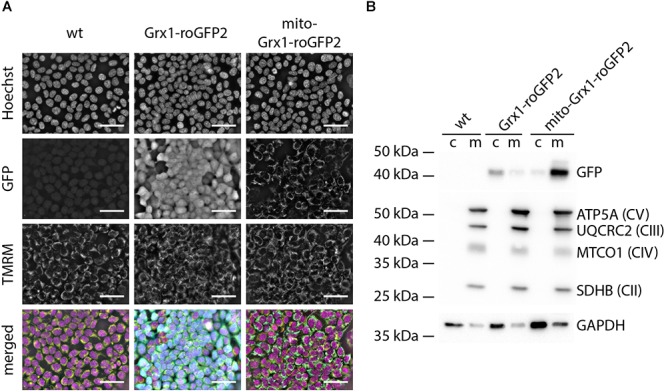
TSA cells express Grx1-roGFP2 in a compartment specific manner. (A) Live cell imaging of roGFP-reporter (GFP), TMRM (mitochondria) and Hoechst (DNA) in TSA cells demonstrated the anticipated cytosolic and mitochondrial localization of Grx1-roGFP2 and mito-Grx1-roGFP2, respectively; note that the GFP signal in the Grx1-roGFP2 condition fills the whole cell, whereas the mito-Grx1-roGFP2 signal superimposes with the spatially confined perinuclear TMRM signal and presents as a distinct rim around the nucleus because of the high nucleus to cytosol ratio in TSA cells. Scale bars: 50 μm. (B) Representative Western blot analysis to confirm enrichment of the respective roGFP2 reporters in cytosolic (c) and mitochondria (m) compartments. The mitochondrial compartment is characterized by proteins of the electron transport chain complexes I - IV (SDHB: Succinate dehydrogenase complex iron sulfur subunit B, MTCO1: Cytochrome c oxidase I, UQCRC2: ubiquinol-cytochrome c reductase core protein II, ATP5A: ATP synthase subunit alpha).